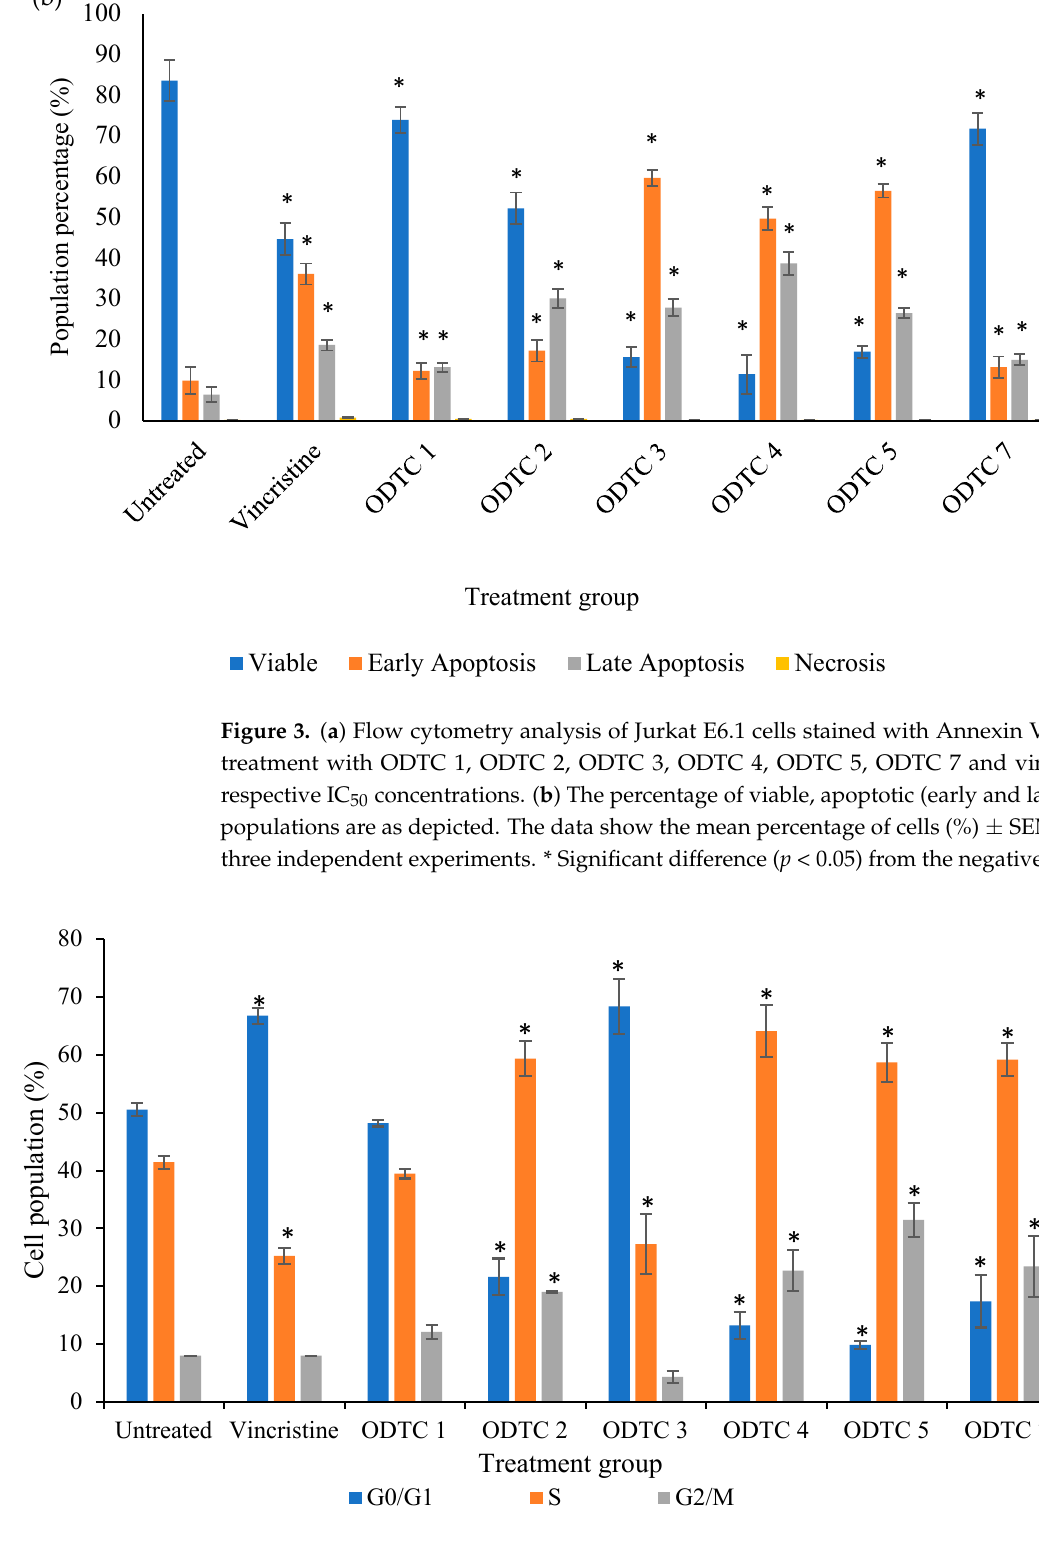
Figure 4. Flow cytometry analysis of Jurkat E6.1 cells stained with RNase/PI and treated with ODTC 1, ODTC 2, ODTC 3, ODTC 4, ODTC 5, ODTC 7 and vincristine at their respective IC 50 concentrations for 24 h. Percentage (%) of cells in G0/G1, S and G2/M is depicted. Data values are the mean ± SEM percentage from three independent experiments. * Significant difference ( p < 0.05) from the negative control. Table 2. Summary of organotin(IV) dithiocarbamate action on the cell cycle phases.